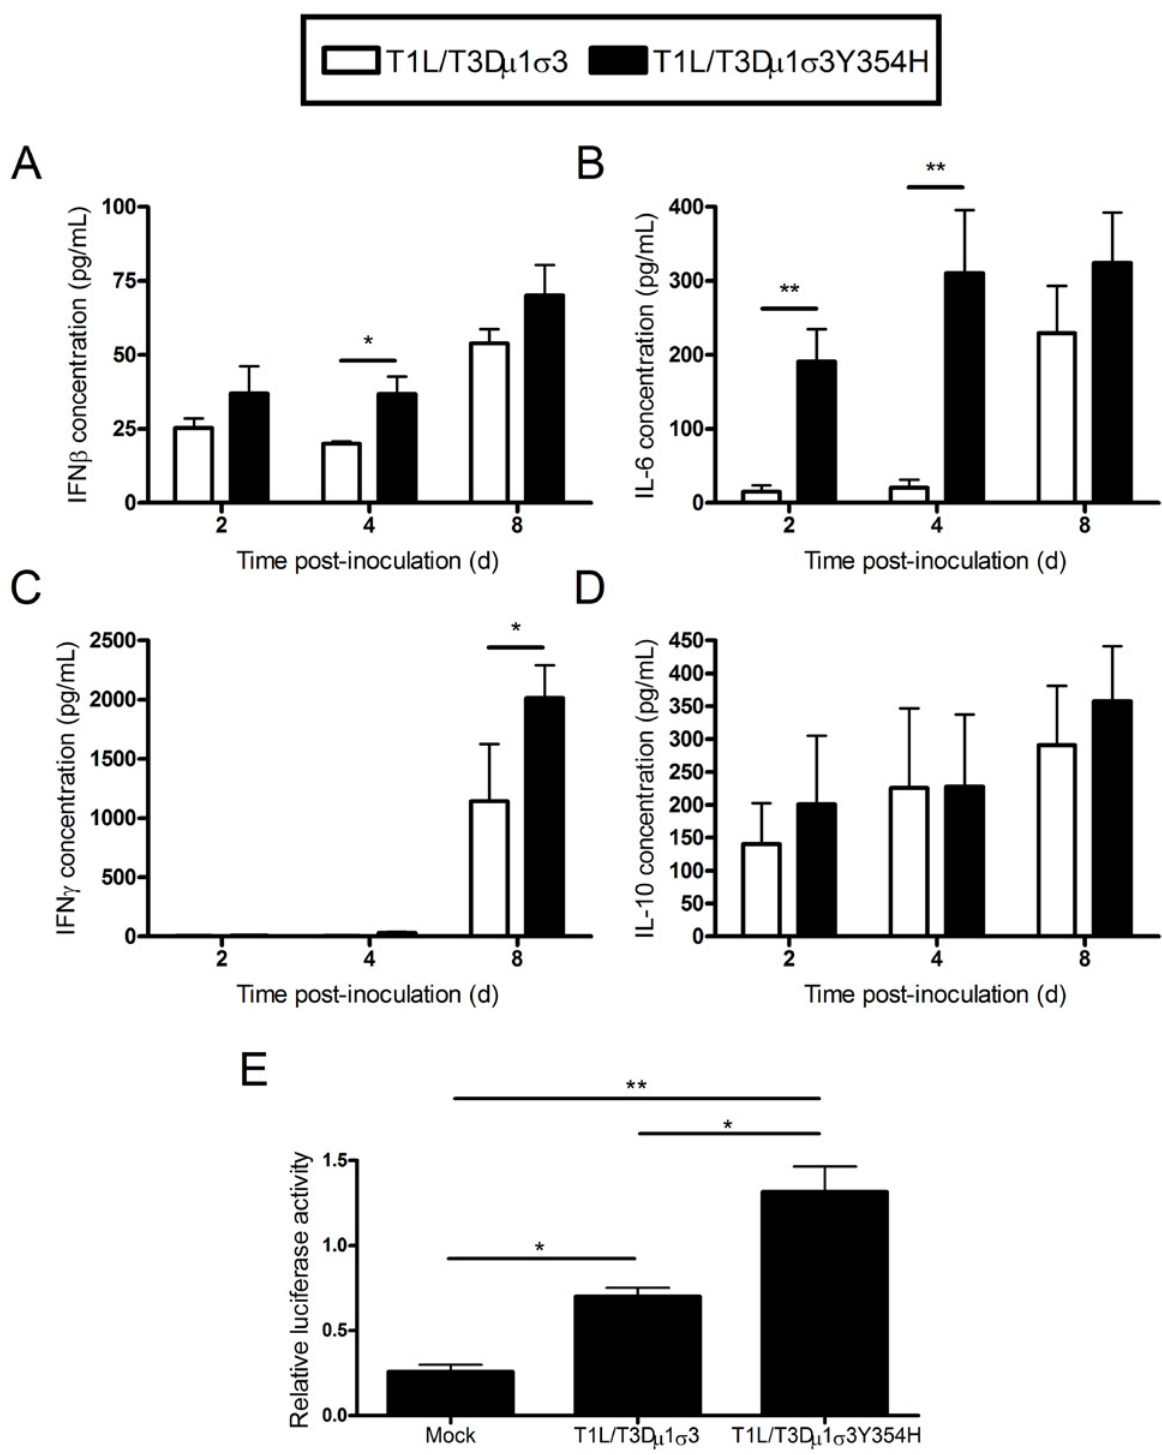
Fig 7. Elevated cytokine levels following infection of mice with T1L/T3D μ 1 σ 3 and T1L/T3D μ 1 σ 3Y354H. (A-D) Newborn C57BL/6J mice were inoculated perorally with 10 3 PFU of either T1L/T3D μ 1 σ 3 or T1L/T3D μ 1 σ 3Y354H. At days 2, 4, and 8 post-inoculation, mice were euthanized, and hearts were excised, frozen at -80°C, thawed, and homogenized in PBS. Levels of IFN β (A), IFN γ (B), IL-6 (C), and IL-10 (D) in heart homogenates were quantified by ELISA. Results are expressed as mean cytokine levels for 4 – 7 animals per time point. (E) Human embryonic kidney cells (293-T) were cotransfected with a plasmid encoding Renilla luciferase as a transfection control and either a PGL firefly luciferase reporter plasmid under the control of the IFN-sensitive